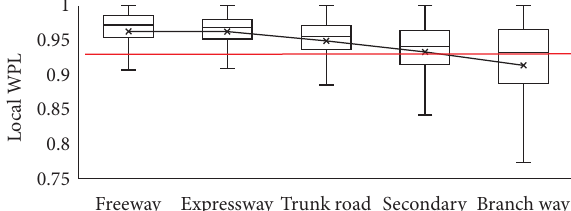
Figure 9: Statistics on the local wayfinding performance level for each road grade.